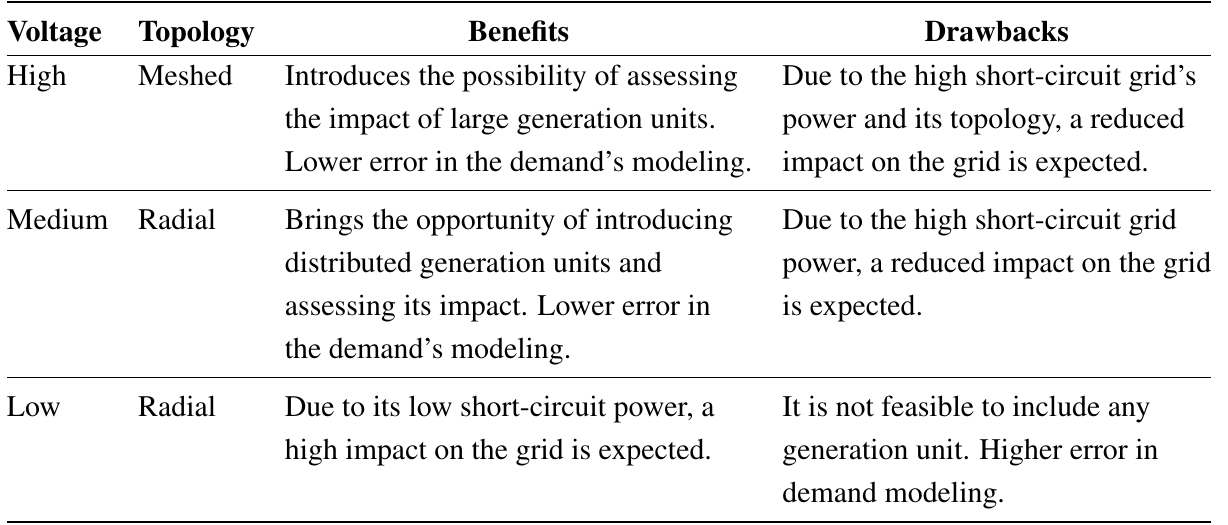
Table 2. Benefits and drawbacks of performing the study with different types of